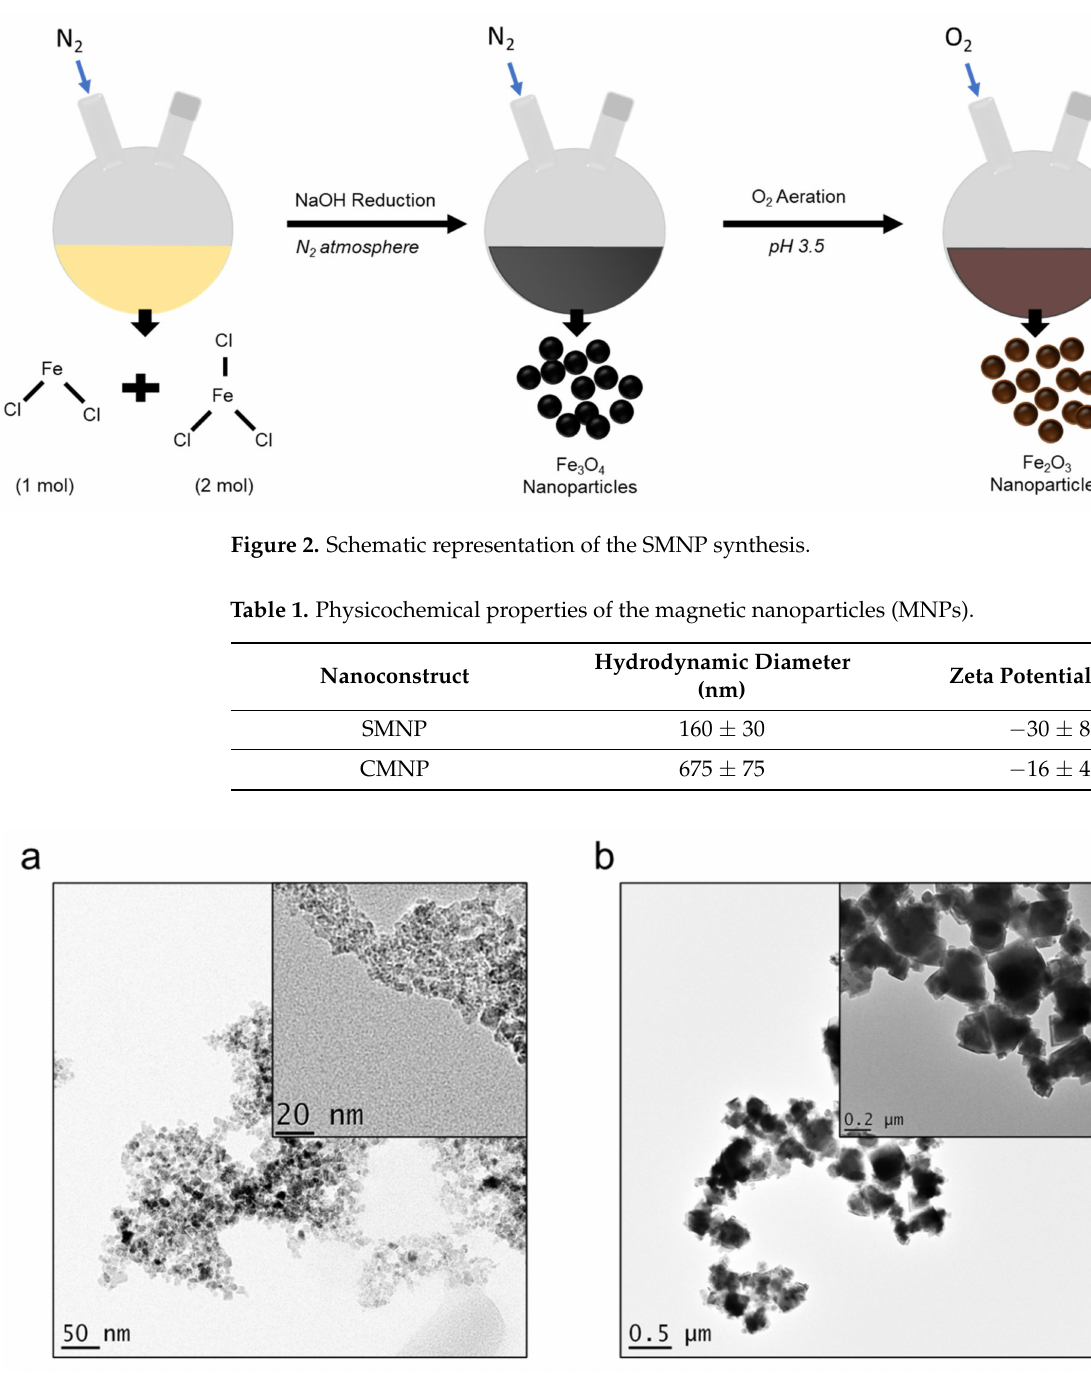
Figure 3. TEM images for the ( a ) SMNP and ( b )